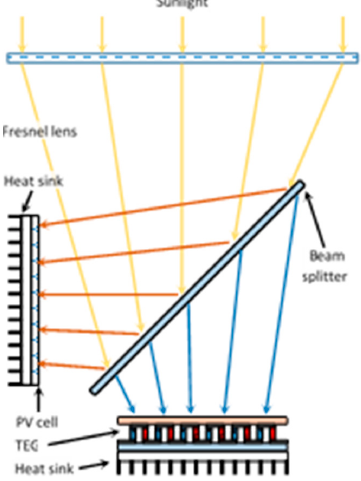
Figure 4. PV-TEG structure with micro-channel heat pipe (MCHP).